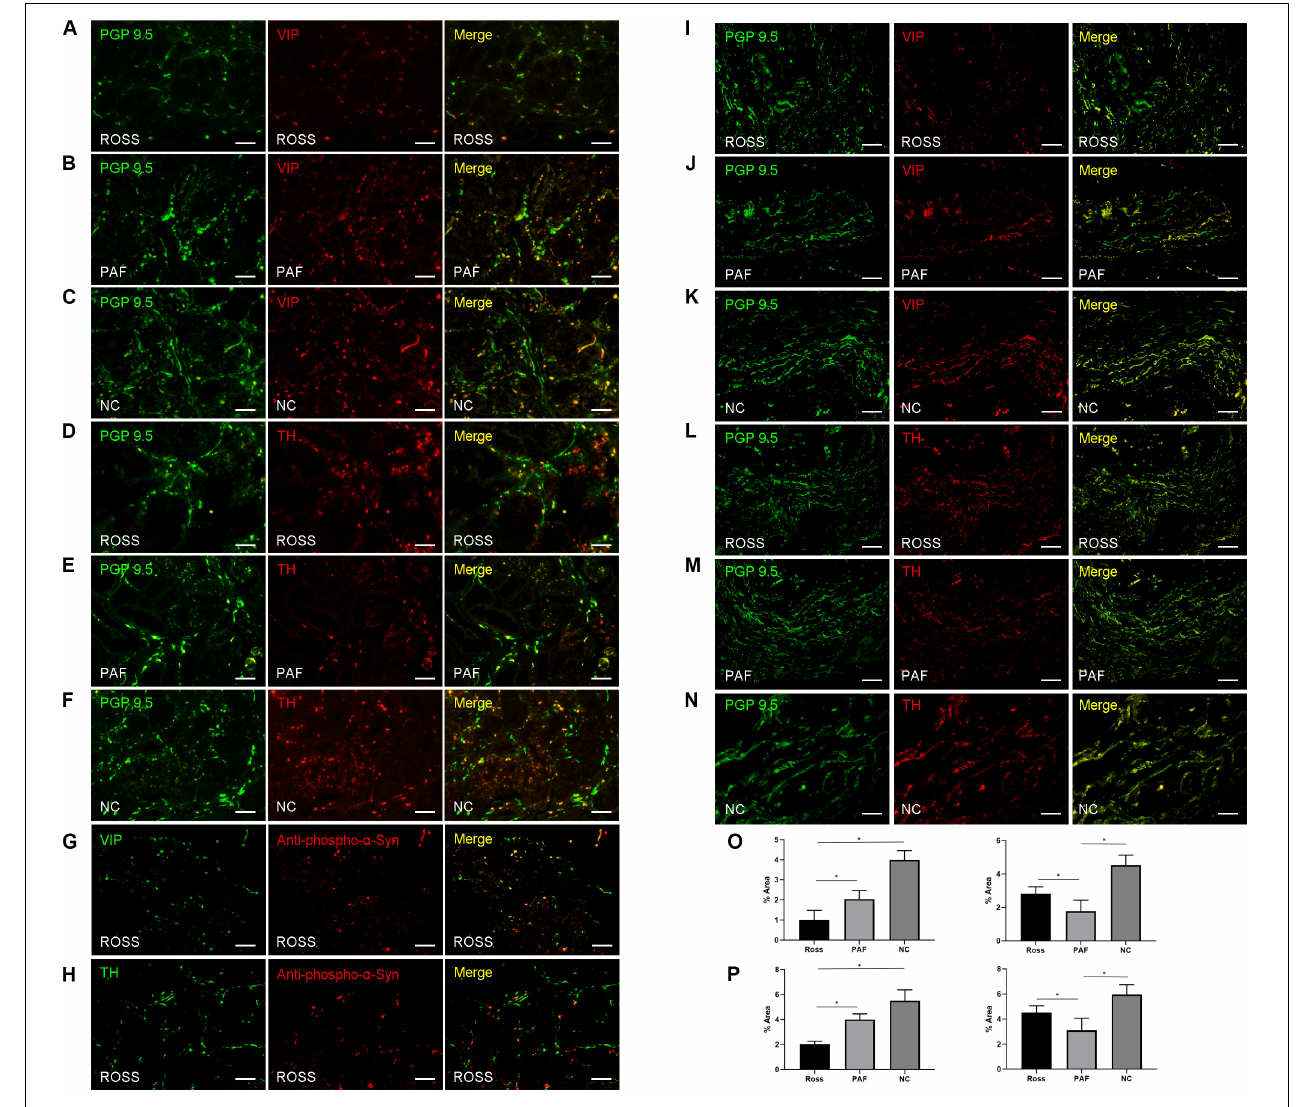
FIGURE 3 | Histopathological features in patients with Ross syndrome, PAF, and normal controls. (A–F) Double immunofluorescence analysis of lesser curvature of stomach: Nerve fibers are marked in green using PGP 9.5; cholinergic fibers and adrenergic fibers are stained in red by anti-VIP and anti-TH antibodies. VIP-ir fibers appear poorly represented in RS (A) , while they were evident in PAF (B) and normal controls (C) . TH-ir fibers were present in Ross patients (D) and normal controls (F) , while they were reduced in PAF (E) . (G,H) Double immunofluorescence analysis of lesser curvature of stomach; VIP-ir p α -Syn (G) appeared more frequently than TH-ir p α -Syn (H) . (I–N) Double immunofluorescence study of urinary bladder innervation. VIP-ir fibers appear poorly represented in RS (I) , while they were evident in PAF (J) and normal controls (K) . TH-ir fibers were present in Ross patients (L) and normal controls (N) , while they were reduced in PAF (M) . (O,P) Quantification